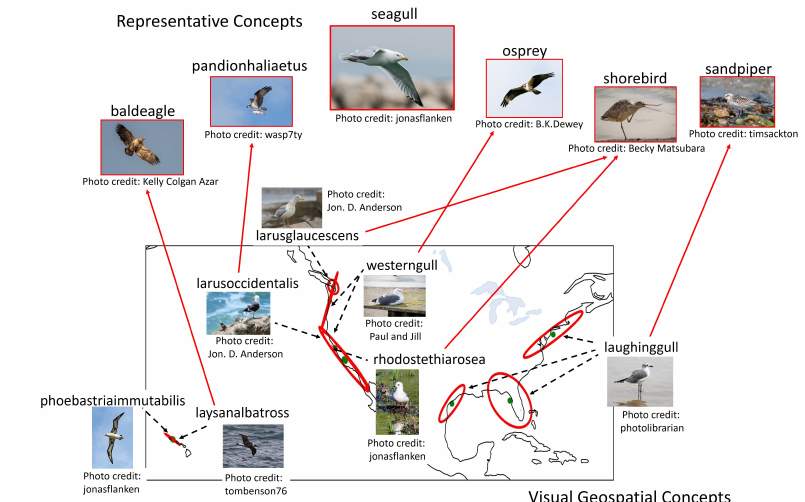
Figure 12. Examples of visual geospatial concepts represented by a visual concept seagull . They can be represented by multiple visually similar visual concepts. Only the edges among the visual geospatial concepts and visual concepts other than seagull are presented for visual